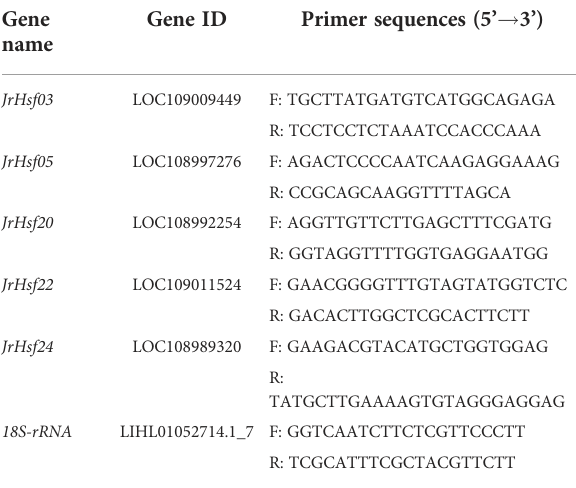
TABLE 1 Speci fi c primer sequences of genes used for qRT-PCR.